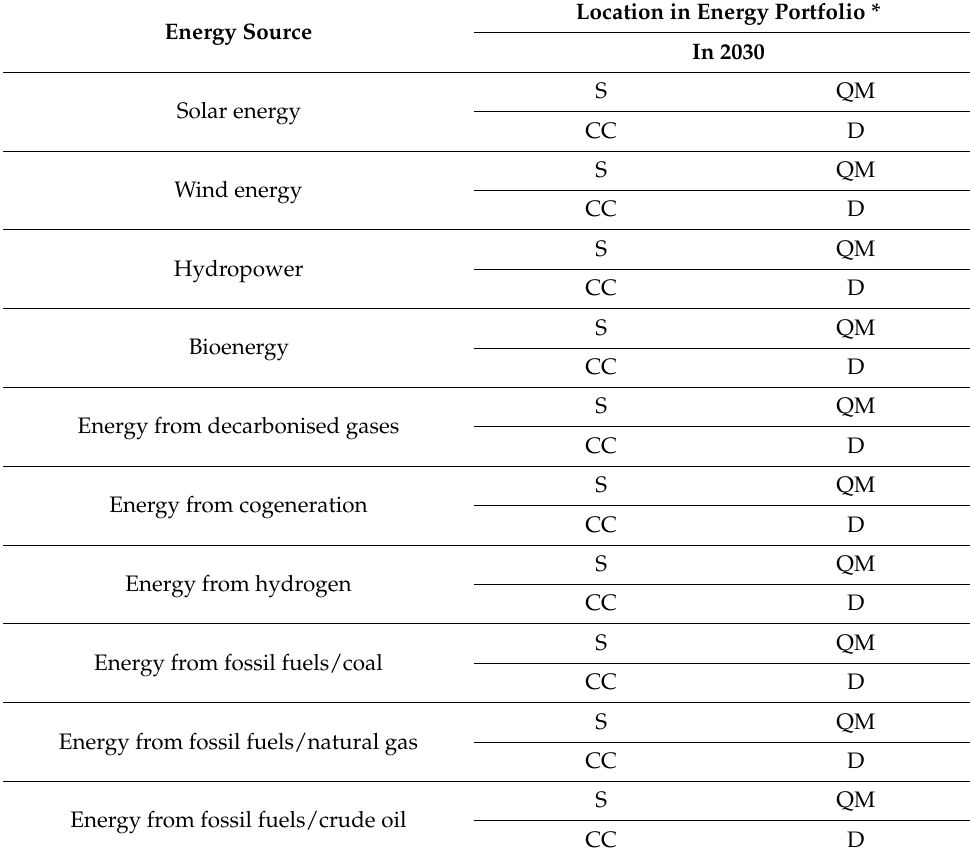
Table 8. Forecast portfolio of energy sources for the Eastern Poland macroregion for 2030— consolidated